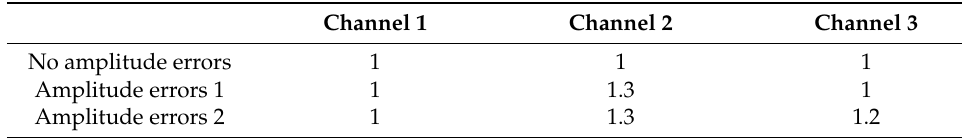
Figure 2. Effect of channel amplitude imbalance. ( a ) Effect of channel amplitude imbalance on the reconstructed filter. The solid black line indicates the response of the reconstruction filter without amplitude error. The colored solid line indicates the reconstruction filter response with channel 2 set to 1.3 times the reference channel amplitude. The colored dashed lines indicate the reconstructed filter responses for channels 2 and 3 with 1.3 and 1.2 times the reference channel amplitude, respectively. ( b ) Effect of channel amplitude imbalance on the reconstructed spectrum. Table 2. Amplitude